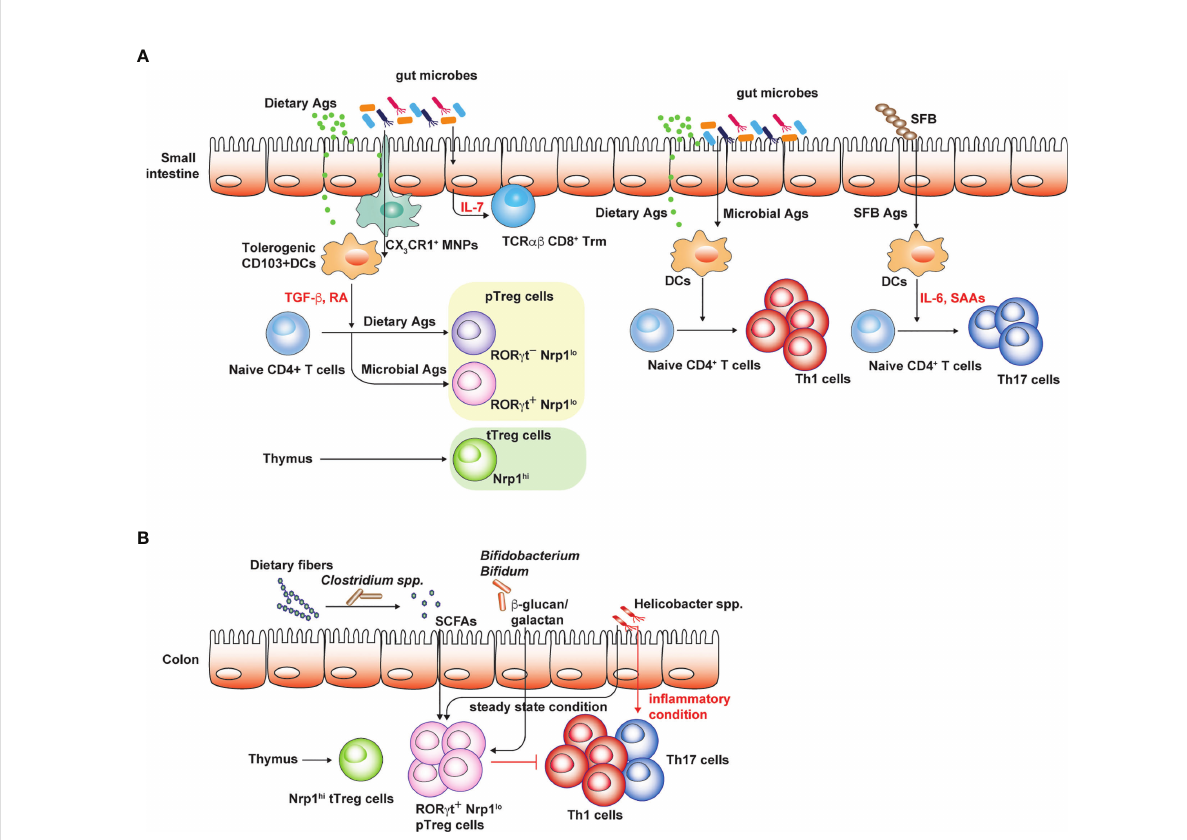
FIGURE 1 Conventional T cell subsets in small intestine and colon. Regulatory and pro-in fl ammatory T cell responses are well-balanced to tightly control overt immune responses against both dietary and microbial Ags. (A) CD103 + DCs in the small intestine are typically tolerogenic and express TGF- b and retinoic acid (RA), which promote peripheral Treg cell generation. Small intestinal Treg cells consist of thymic Treg cells speci fi c to self-Ags or presumably microbial Ags, the latter delivered into the thymus by CX3CR1 mononuclear phagocytic cells in early-life. ROR g t + Nrp1 lo pTreg cells are thought to be induced by gut microbiota while ROR g t - Nrp1 lo pTreg cells are generated by dietary Ags. These intestinal Treg cells limit intestinal proin fl ammatory Th1 and Th17 cell responses against dietary Ags and gut microbiota. IL-7 produced by epithelial cells in gut microbiota-dependent manner promotes the survival and maintenance of tissue resident TCR ab CD8 + T cells. (B) Colonic Treg cells largely consist of ROR g t + pTreg cells and thymic Treg cells. Broad spectrum of microbes can induce pTreg cells through various mechanisms. Under steady state condition, colonic Th17 cells are rare relative to Th1 cells and certain pathobiont species such as Helicobacter spp. promote Treg cell generation. However, in in fl ammatory settings, these pathobiont species effectively induce colonic Th17 cell responses. The fi gure was created with Adobe